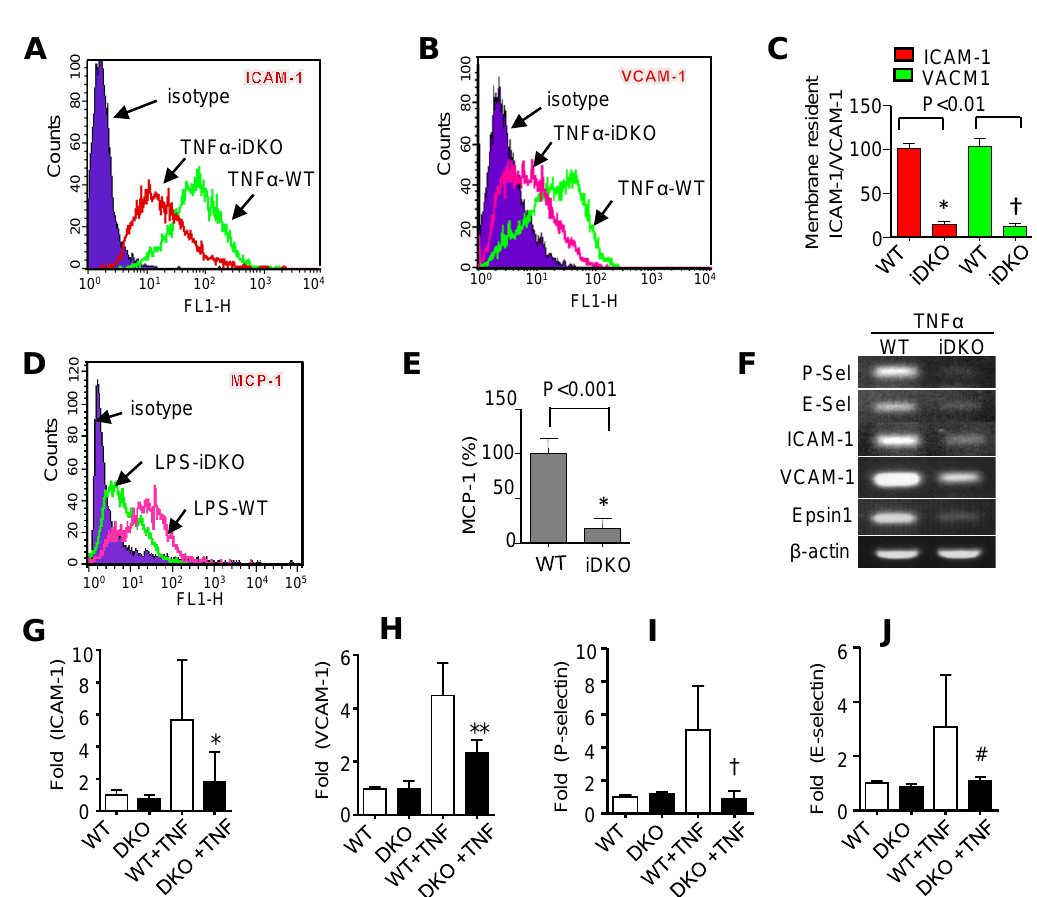
Figure 3. Loss of endothelial epsins impairs expression of inflammatory genes. ( A , B ) Cell surface presentation of adhesion molecules (ICAM-1 and VCAM-1) as determined by flow cytometry after treatment with 50 ng/mL TNF- α for 16 h (n = 3). ( C ) Statistical histogram for B and C (* or †, p < 0.01). ( D , E ) Cell surface presentation of MCP-1 by flow cytometry after stimulation with 1 µ g/mL LPS for 3 h (n = 3). ( E ) Quantification for ( D ). ( F ) Expression of adhesion molecules in WT and DKO MAECs after 50 ng/mL TNF- α stimulation for 3 h analyzed as determined by unsaturated PCR analysis and agarose gel electrophoresis. ( G – J ) Analysis of adhesion molecules (ICAM-1 and VCAM-1) and selectins (P- and E-selectin) in MAECs stimulated with TNF α (50 ng/mL) for 3 h, followed by extraction of total RNA, cDNA synthesis, and real-time qRT-PCR (n = 3–5; *, **, †, or #, p < 0.05).